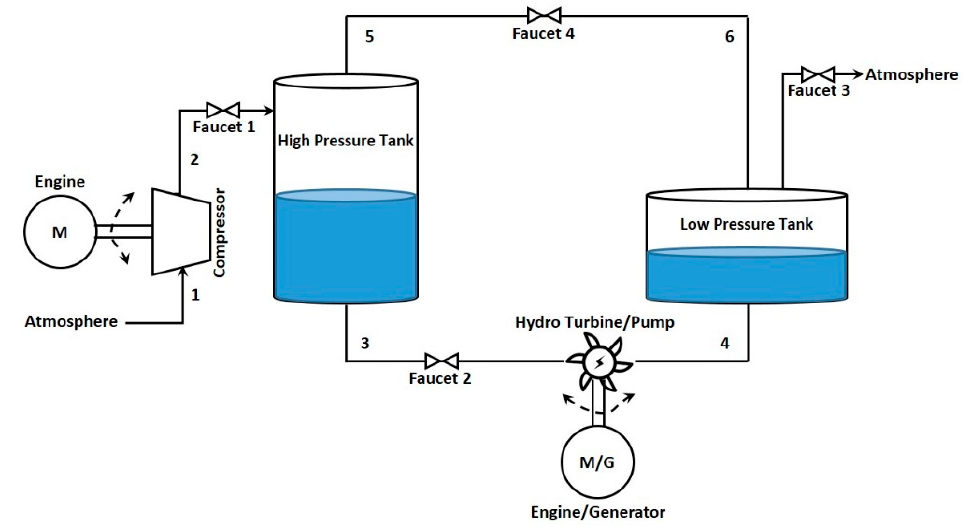
Figure 1. A schematic view of the combined energy storage system of compressed air and the stor- age pump. storage